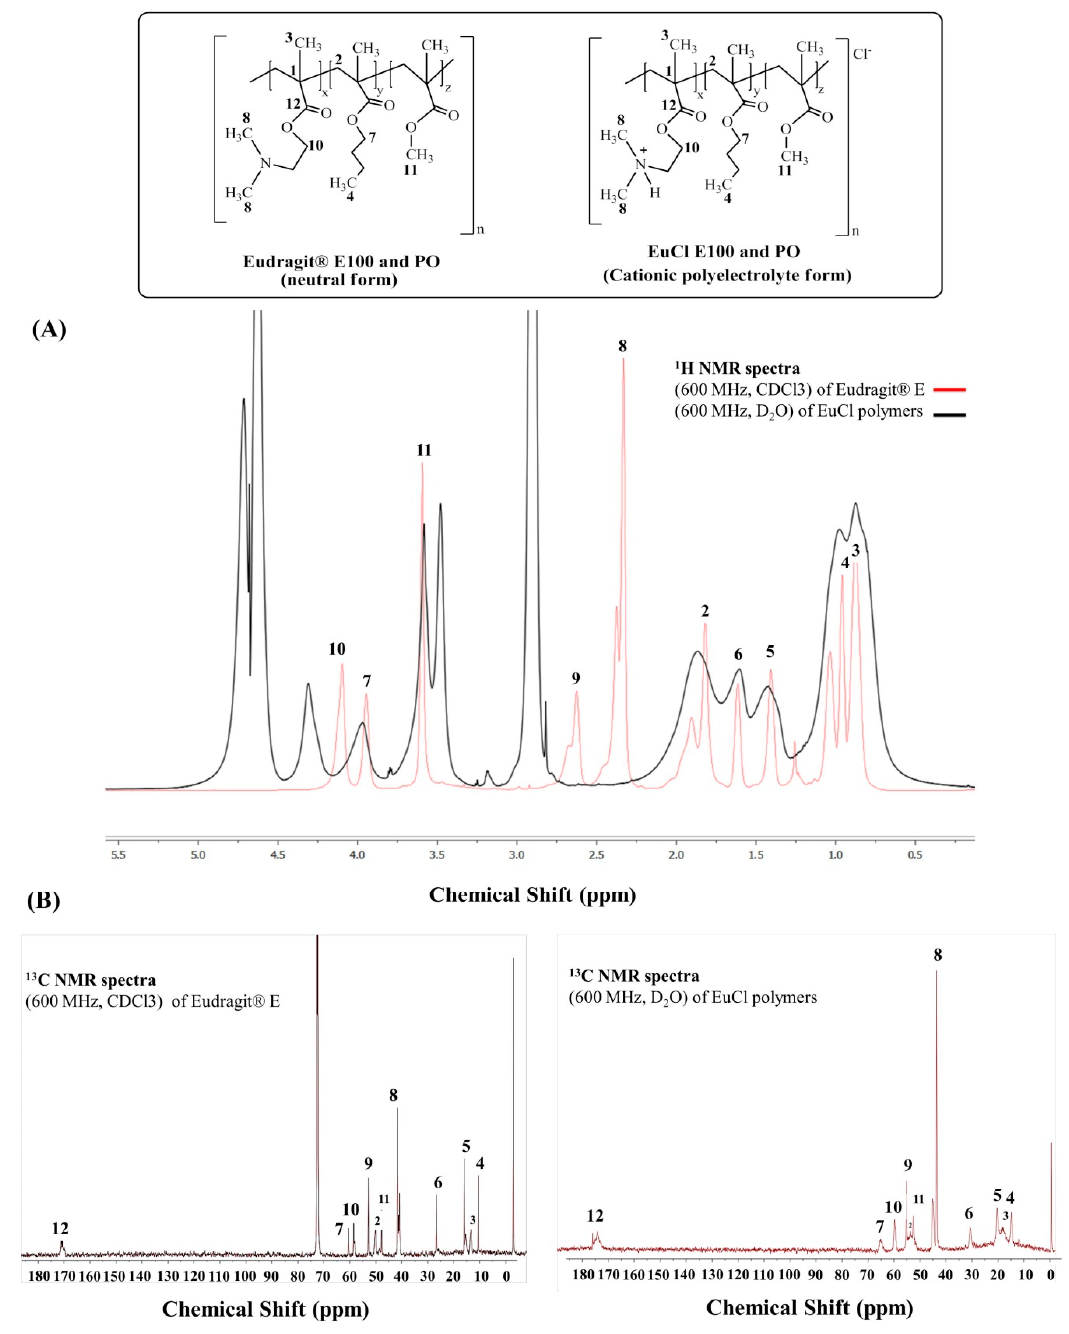
Figure 3. Comparison of the ( A ) proton and ( B ) carbon NMR spectra of Eudragit ® and its processed forms.